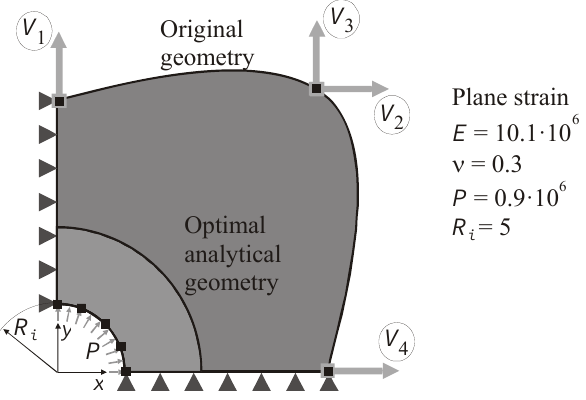
Fig. 1. Pipe cross section. Analysis data, original model, optimal analytical solution and design variables